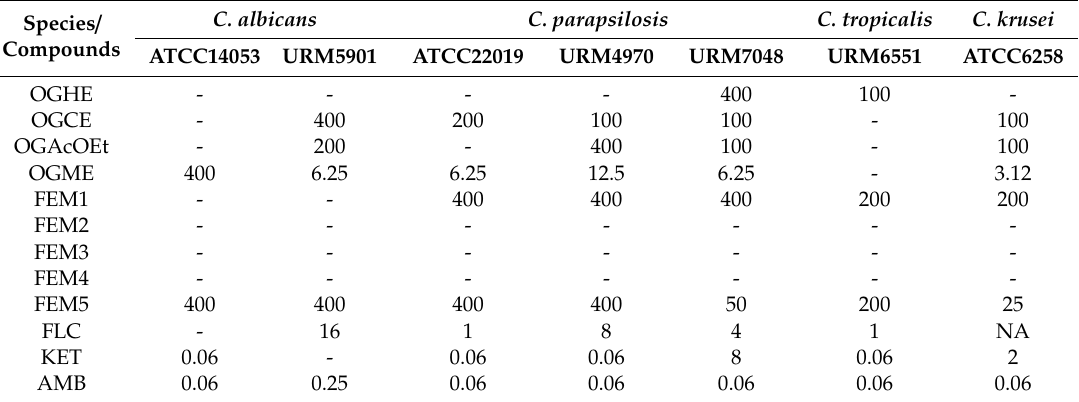
Table 2. Minimal inhibitory concentration (MIC) of synthetic antifungals, extracts and active fractions of the O. glomerata methanol extract ( µ g /